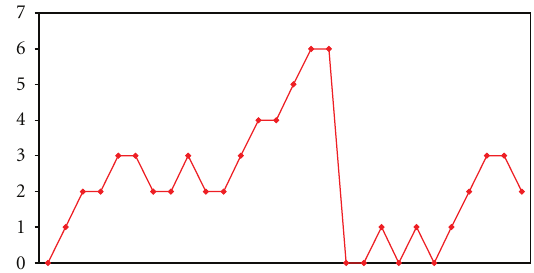
Figure 2: A gastroparesis patient with a great deal of symptomatic variability from clinical encounter to clinical encounter.